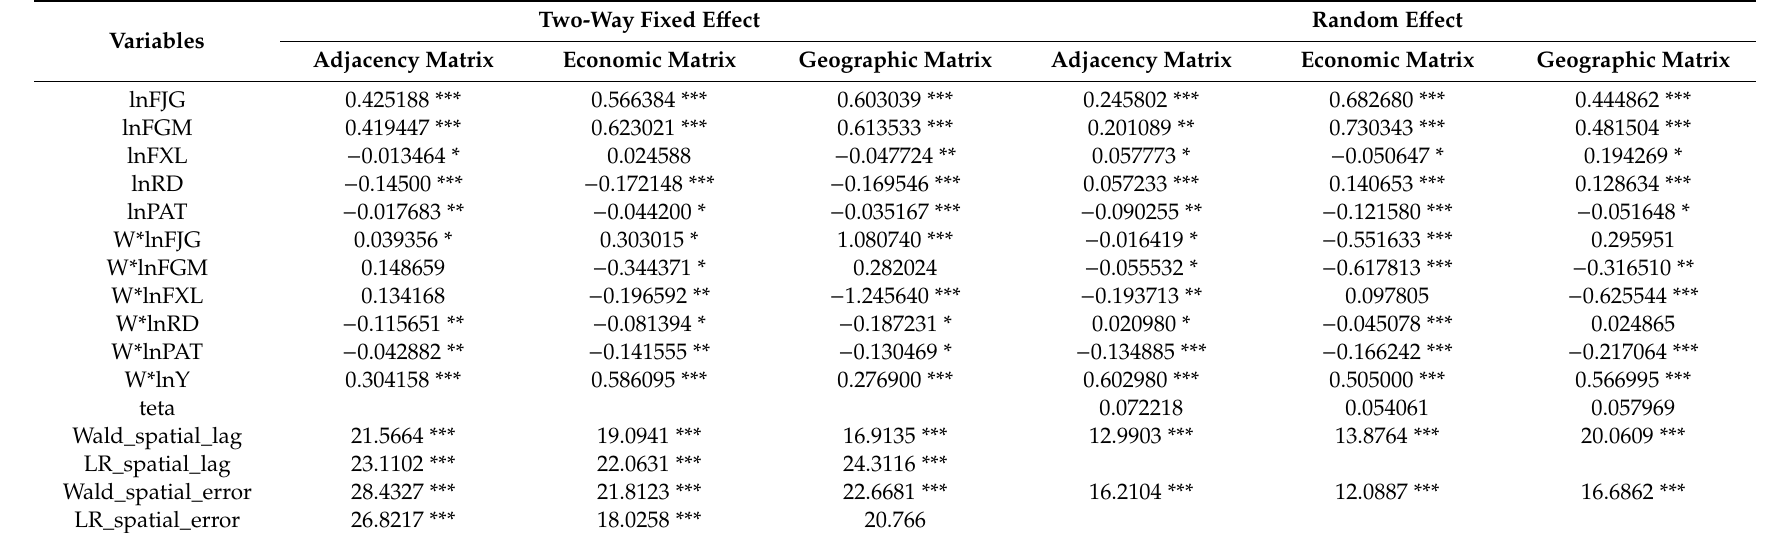
Table 3. Spatial Durbin model estimation and